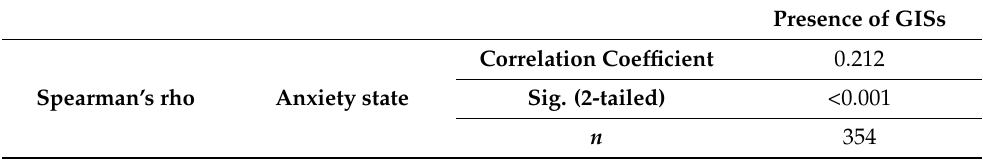
Table 2. Correlation between anxiety state and presence of GISs.